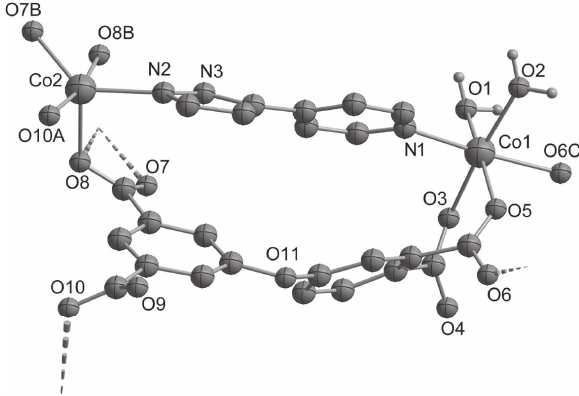
Table 1: Data collection and handling.